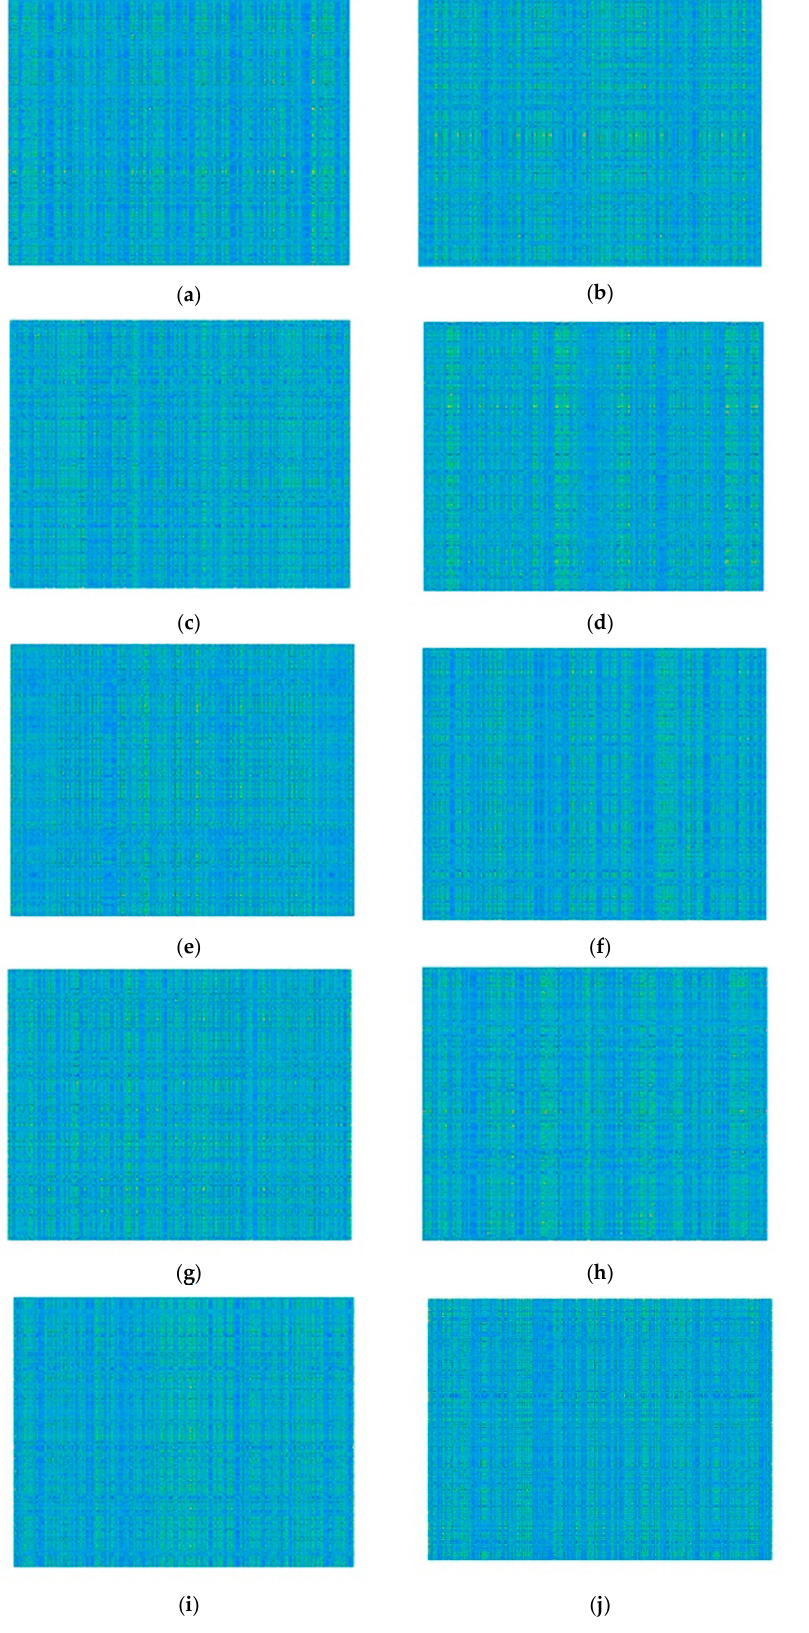
Figure 7. Ten confused DEM